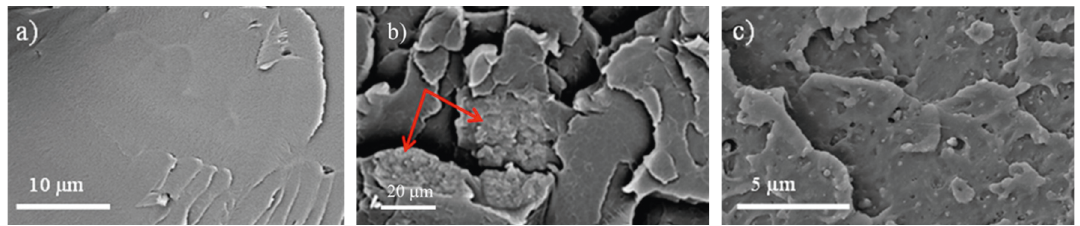
Figure 5: SEM images of surface cryofractured of (a) PSU, (b) PSU2_Ext (the arrows show aggregates), and (c)